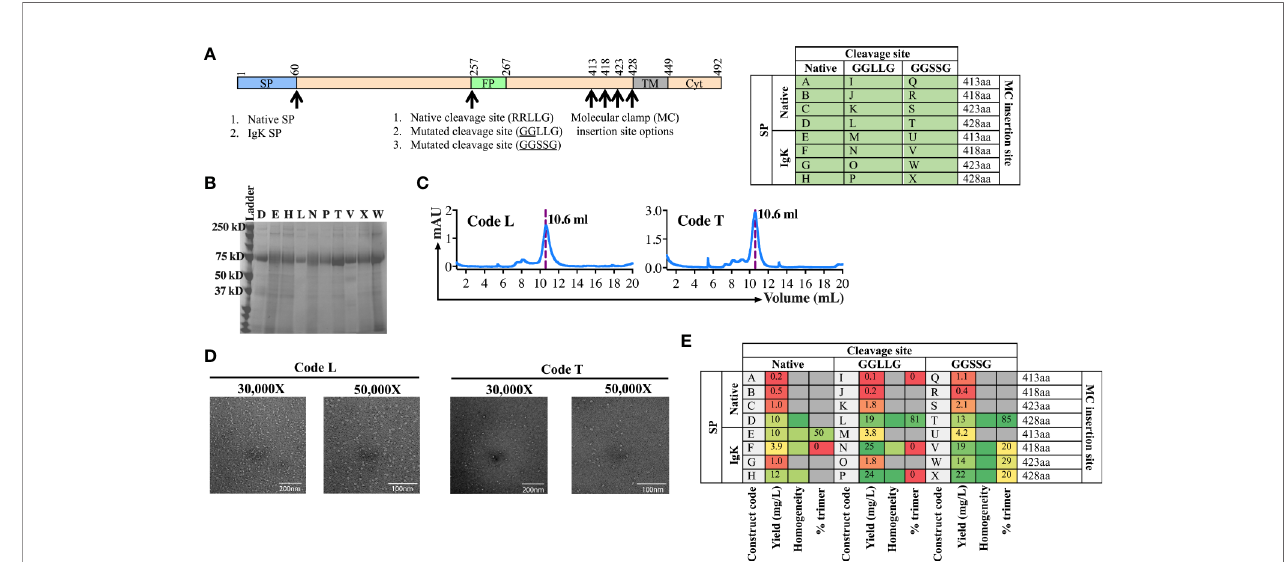
FIGURE 4 | Production and analysis of WENV GPclamp antigens. (A) The cloning strategy delineating the 24 different WENV GPclamp constructs and the table shows the alphabetized (A – X) construct codes based on the different permutations of signal peptides, cleavage sites, and the Molecular Clamp insertion. The mutations introduced to the putative native cleavage site are underlined. (B) SDS-PAGE analysis of the 10 highest expressing WENV GPclamp proteins under reducing conditions. (C) Representative size exclusion chromatographs for construct codes L and T which were the two highest expressing constructs also comprising of the highest proportion of trimer among the puri fi ed GPclamp protein solution. The dotted line overlaps with the trimer peak and the elution volume of this peak is indicated. (D) Representative 30,000× and 50,000× images of the TEM negative stain analysis of the trimeric fraction from the size excluded WENV GPclamp codes L and T. (E) Summary of the puri fi cation and in vitro analysis of the WENV Fclamp constructs highlighting the expression yield, percentage of the puri fi ed protein in the trimeric conformation, and the homogeneity of the proteins on an SDS-PAGE. For the homogeneity analysis: red shaded = least homogenous or no proteins corresponding to WENV-GPclamp, yellow shaded = intermediate homogeneity, and green shaded = highly homogenous. Gray shaded boxes indicate when the respective protein analysis were not